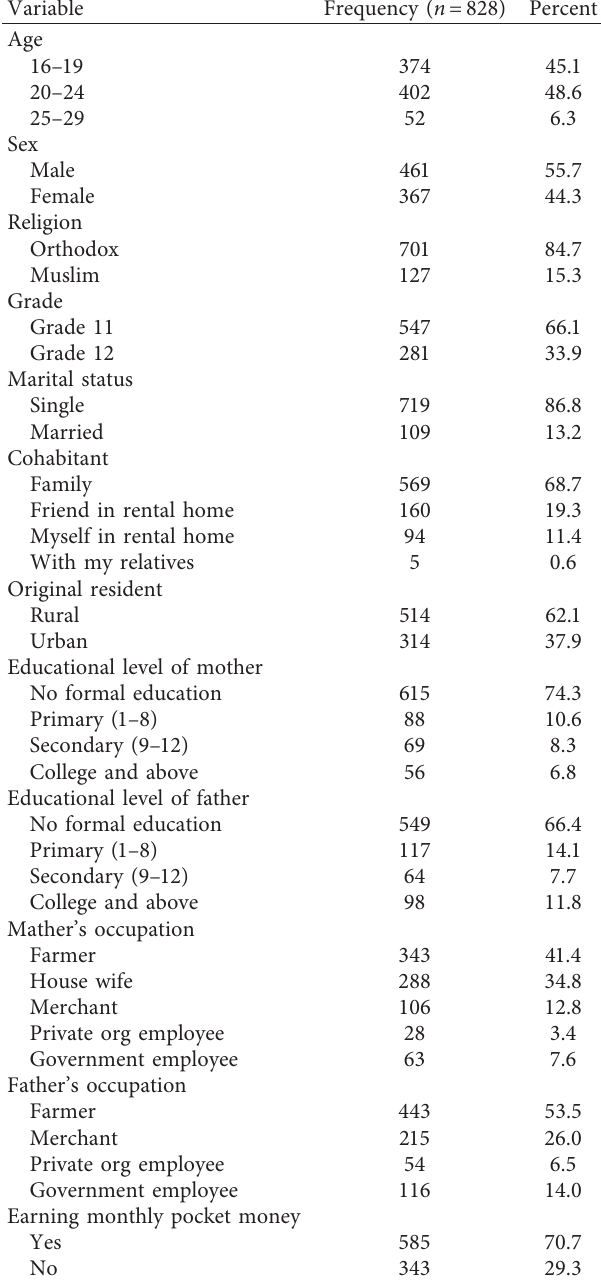
Table 1: Sociodemographic characteristics of preparatory school students in selected West Gojjam zone schools, Northwest Ethiopia,